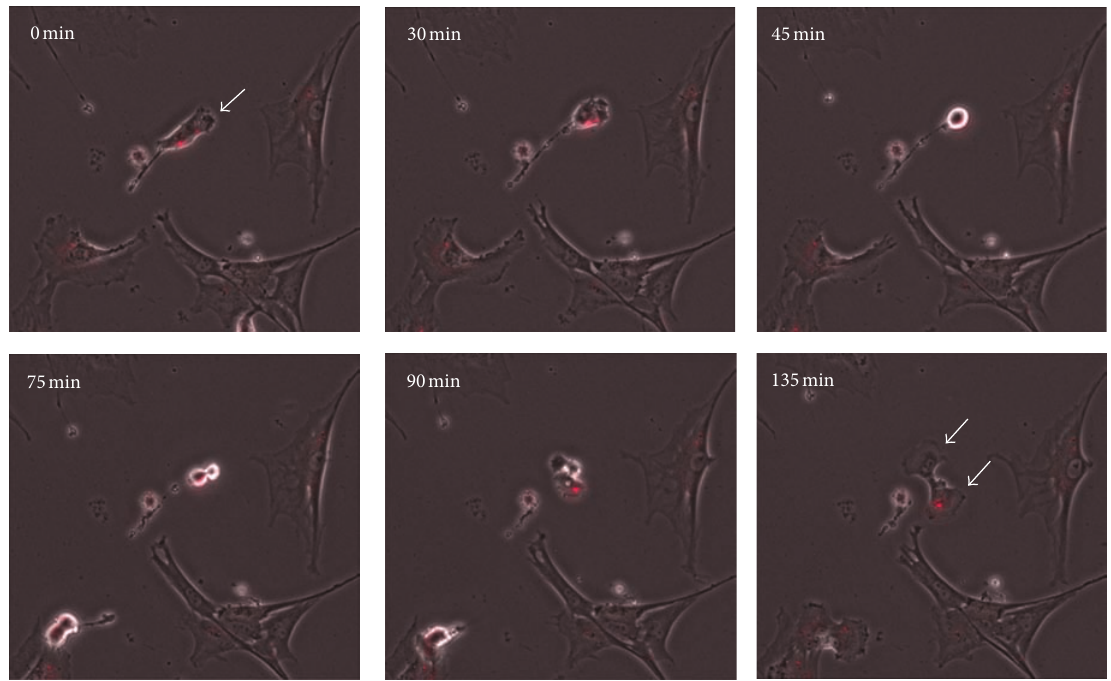
Figure 6: Time-lapse study showing unequal passing on of QDs during cell division (see arrows). Selected microscopy images acquired during cultivation of labeled cells show a time period of 135 min. Overlay images were created from the fluorescent and the phase contrast